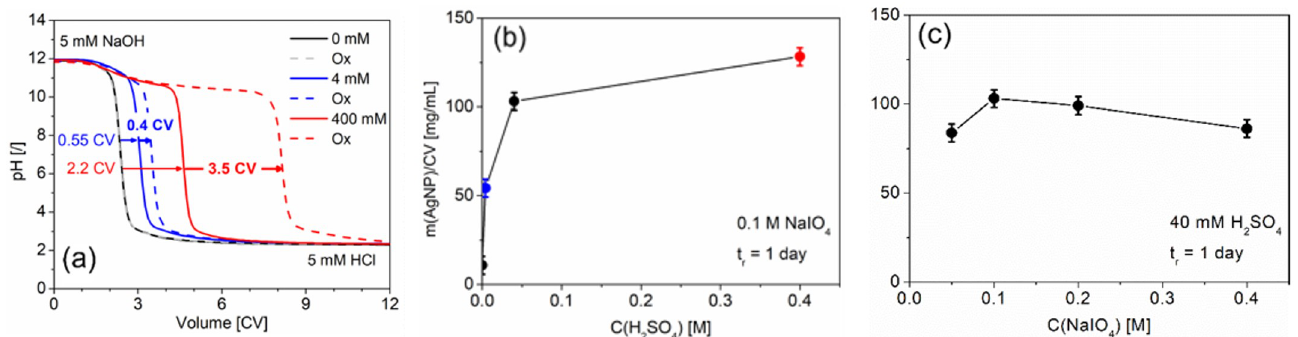
Figure 2. ( a ) Titration curves before and after the oxidation with H 2 O 2 . Arrows show the change in column volume (CV, volume divided by the volume of the column) in titration length between both reaction steps. ( b ) Normalized mass of deposited AgNPs vs. H 2 SO 4 concentration. Blue and red dots show samples that were used for the titration. ( c ) Normalized mass of deposited AgNPs vs. NaIO 4 concentration. Mass of AgNPs is normalized to CV ( ≈ 0.5 mL). The maximal theoretical m(AgNP)/CV was ≈ 690 mg/mL and the reaction time was 1